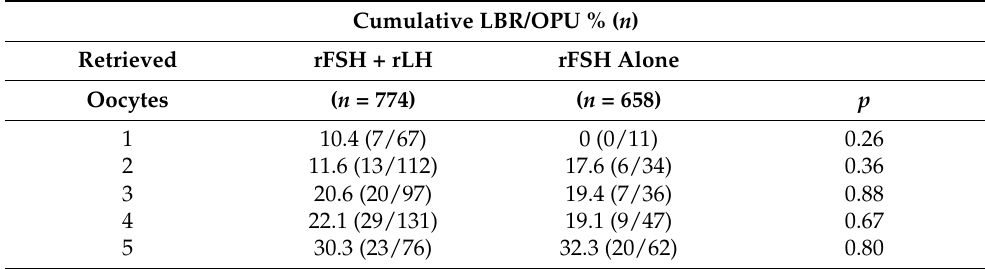
Table 3. Cumulative live birth rates of all patients with available oocytes ( n = 1432) receiving COS with rFSH + rLH ( n = 774) or rFSH alone ( n = 658), stratified for to the number of retrieved oocytes at OPU. Data are expressed as absolute values and